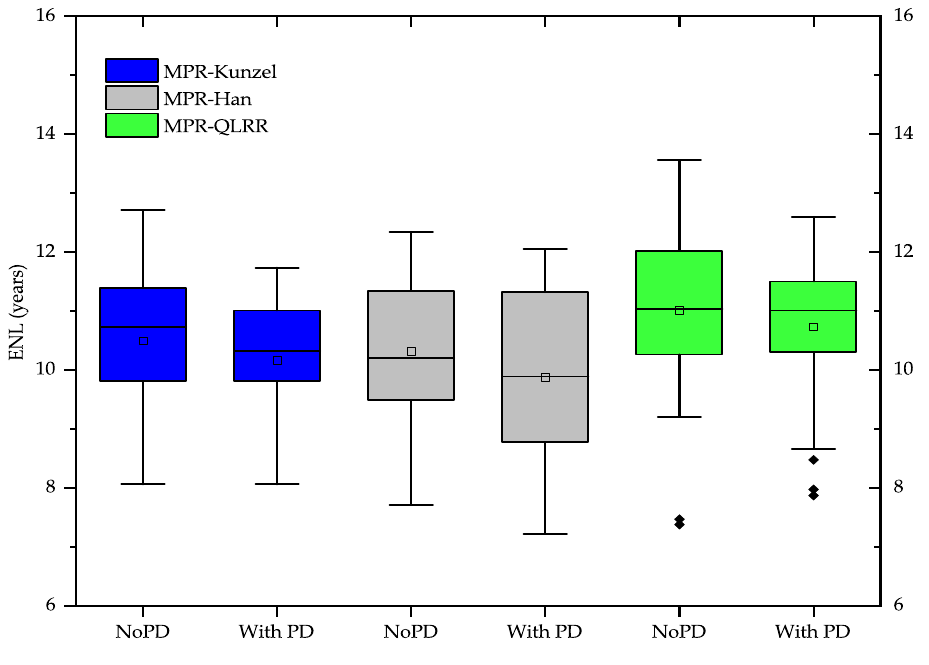
Figure 9. ENL with and without packet drop.